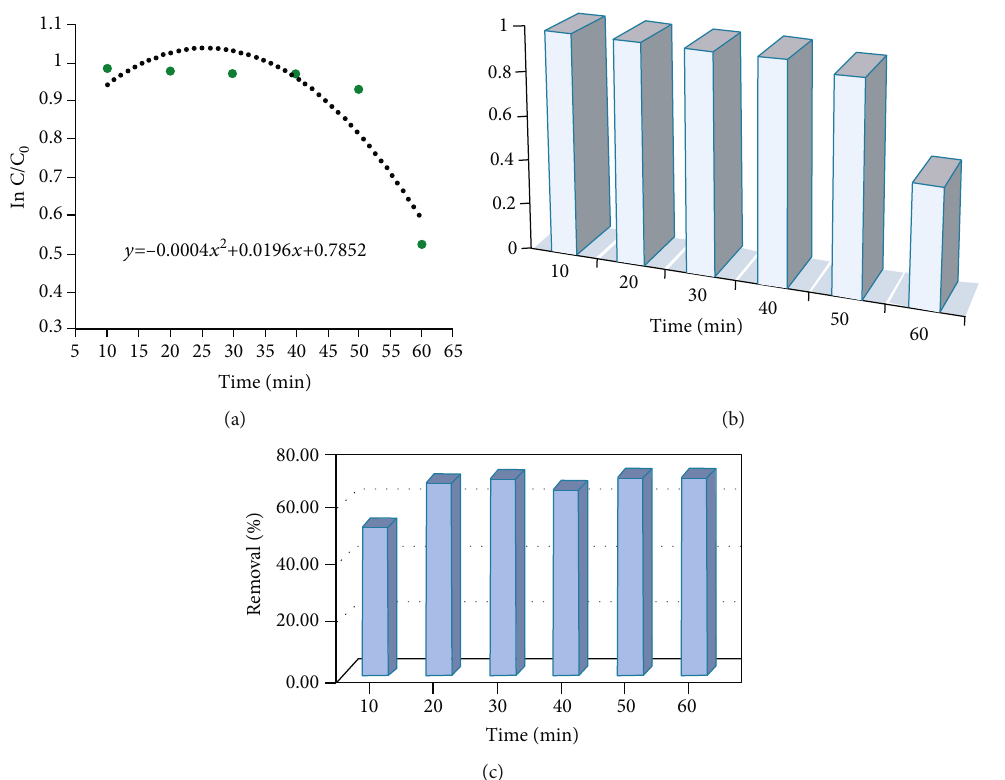
Figure 10: Degradation kinetics studies: (a, b) degradation rate of ISA for methylene blue dye degradation with time and (c) degradation percentage of methylene blue dye using incense stick